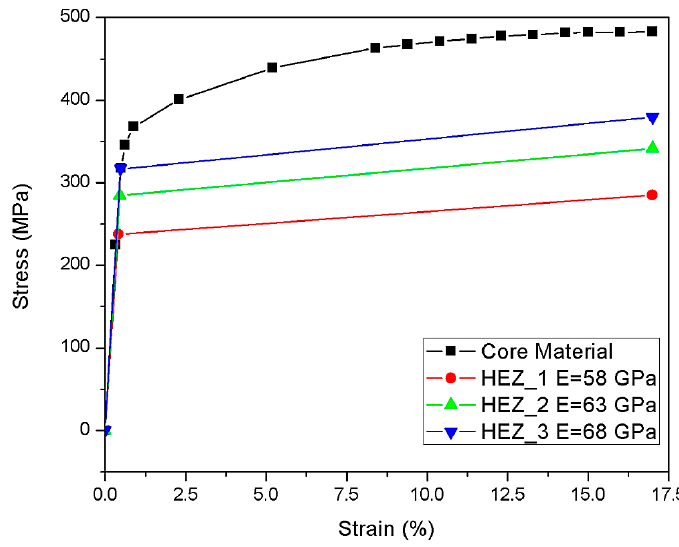
Figure 6. Materials employed in the definition of the HEZ.